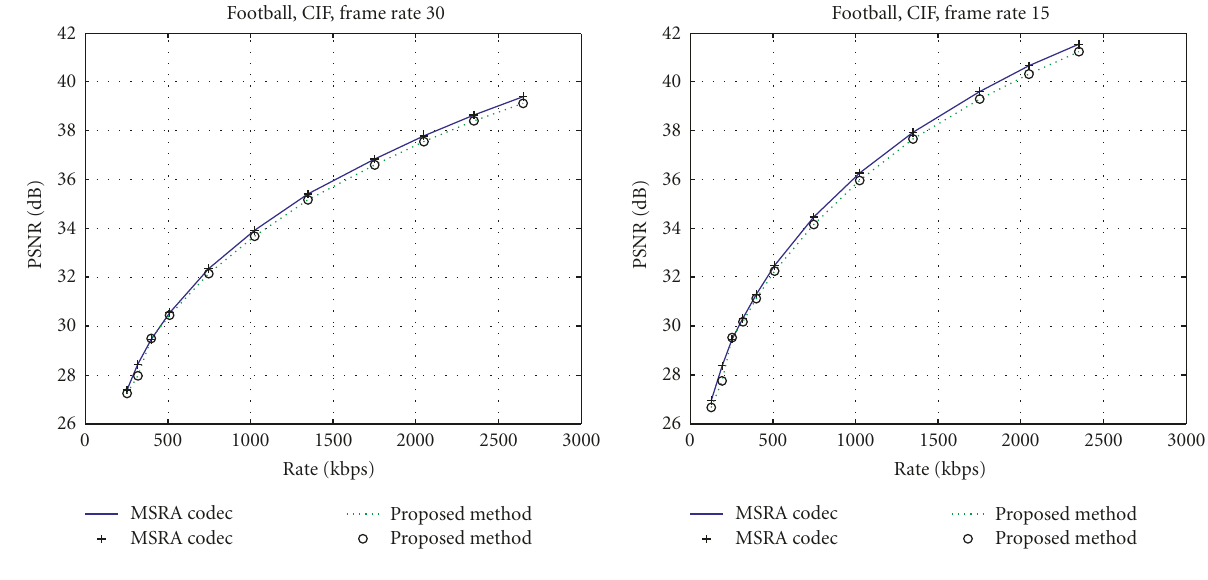
Figure 9: PSNR performance comparison of Football.